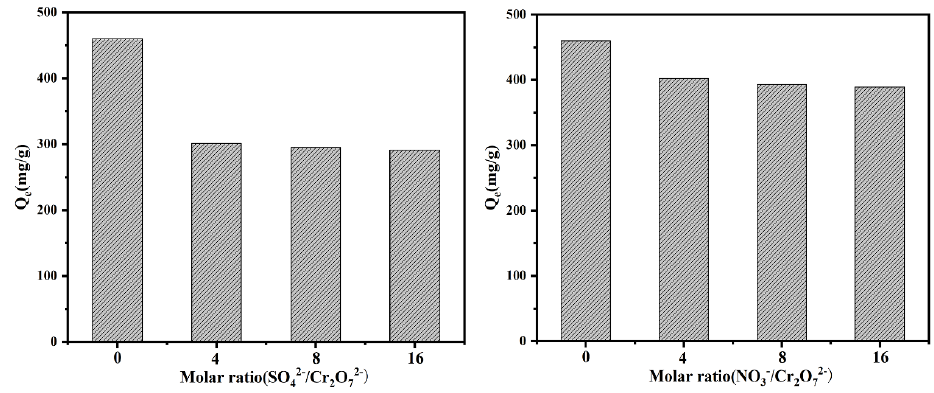
Figure 6. The effect of competing ions on the removal behavior towards Cr(VI).